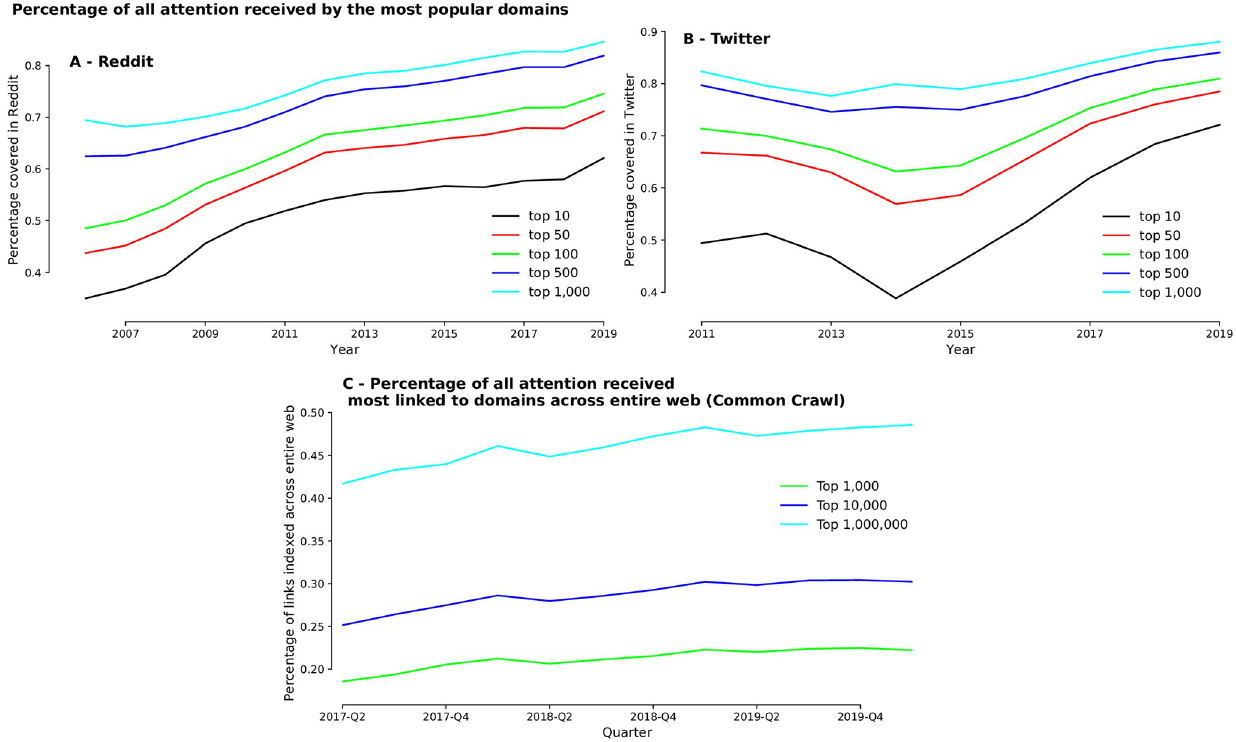
Fig 2. Top websites attract growing percentages of overall links across the entire web. (A)(B) Percentage of all links associated with the most popular 10, 50, 100, 500 and 1,000 domains in Reddit (A) and Twitter (B). The top 10 most popular domains in Reddit received around 35% of all links in 2006, which grew to 60% in 2019. In Twitter, the top 10 domains grep from 50% (2011) to 70% (2019). (C) The sum of PageRank values for the top 1,000, 10,000 and 1 Million domains respectively within the Common Crawl corpus.